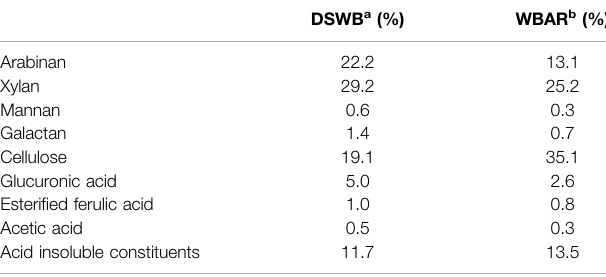
TABLE 1 | The content of different components in de-starched wheat bran and wheat bran autohydrolysis residue. DSWB a (%)